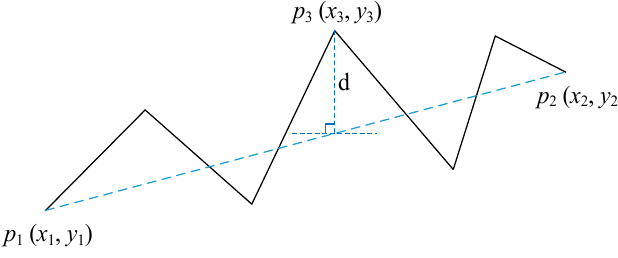
Figure 1. The vertical distance from the point to the line connecting adjacent important points. Table 1. Perceptually Important Point algorithm. Algorithm 1: Perceptually Important Point